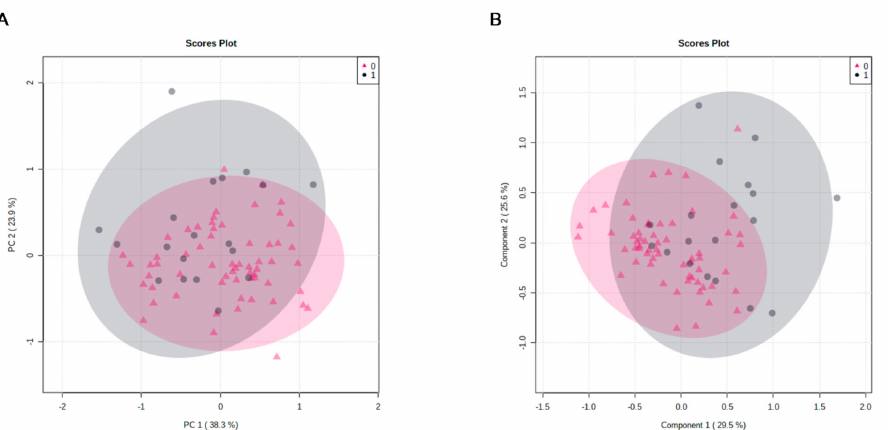
Figure 1. PCA (panel A ) and PLS-DA (panel B ) component analysis score plot between the selected principal components. PCA, principal component analysis; PLS-DA, partial least-squares discrimi- nant analysis; 0 refers to lower oxidative stress (Q1–Q3 nitrotyrosine) group (pink triangle); 1 refers to highest oxidative stress (Q4 nitrotyrosine) group (grey